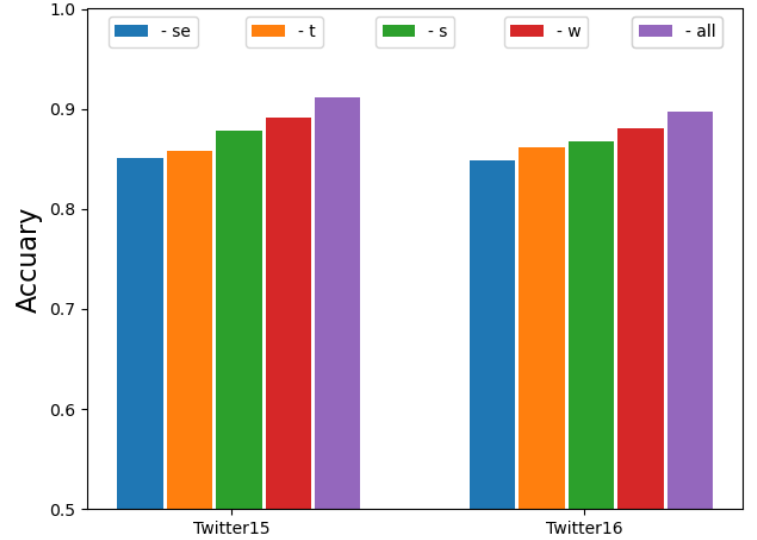
Figure 3. The results of ablation